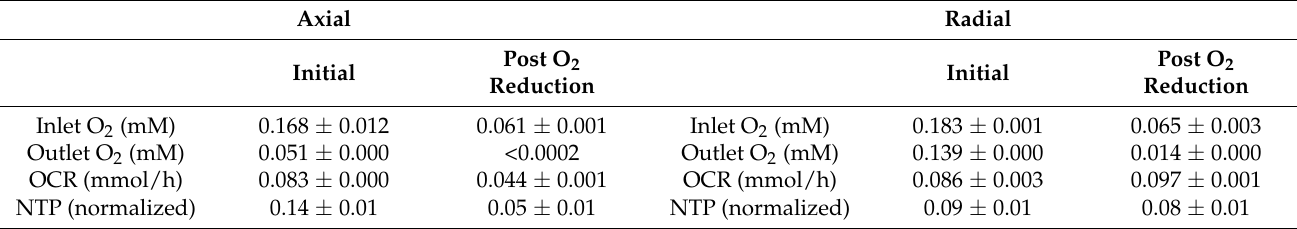
Table 1. Effects of oxygen limitation on oxygen consumption rate and total NTP levels for axial and radial flow. Cells were perfused with DMEM-S before the oxygen reduction and DMEM-I after the oxygen reduction.